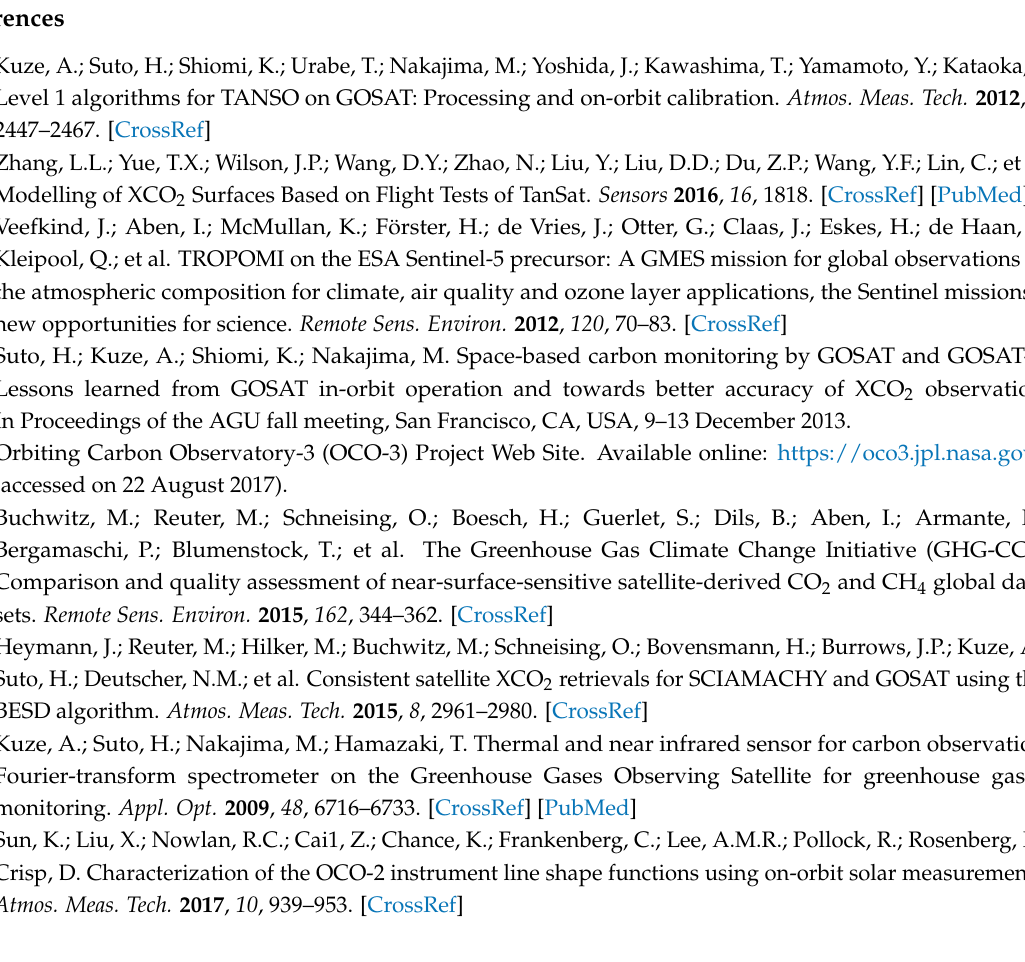
Figure A3. The spectral comparison between glint GOSAT and glint OCO-2 over the Sahara desert at 25.14° N, 7.13° W on 18 February 2015 with the GOSAT medium gain. The plots are same as Figure A1.